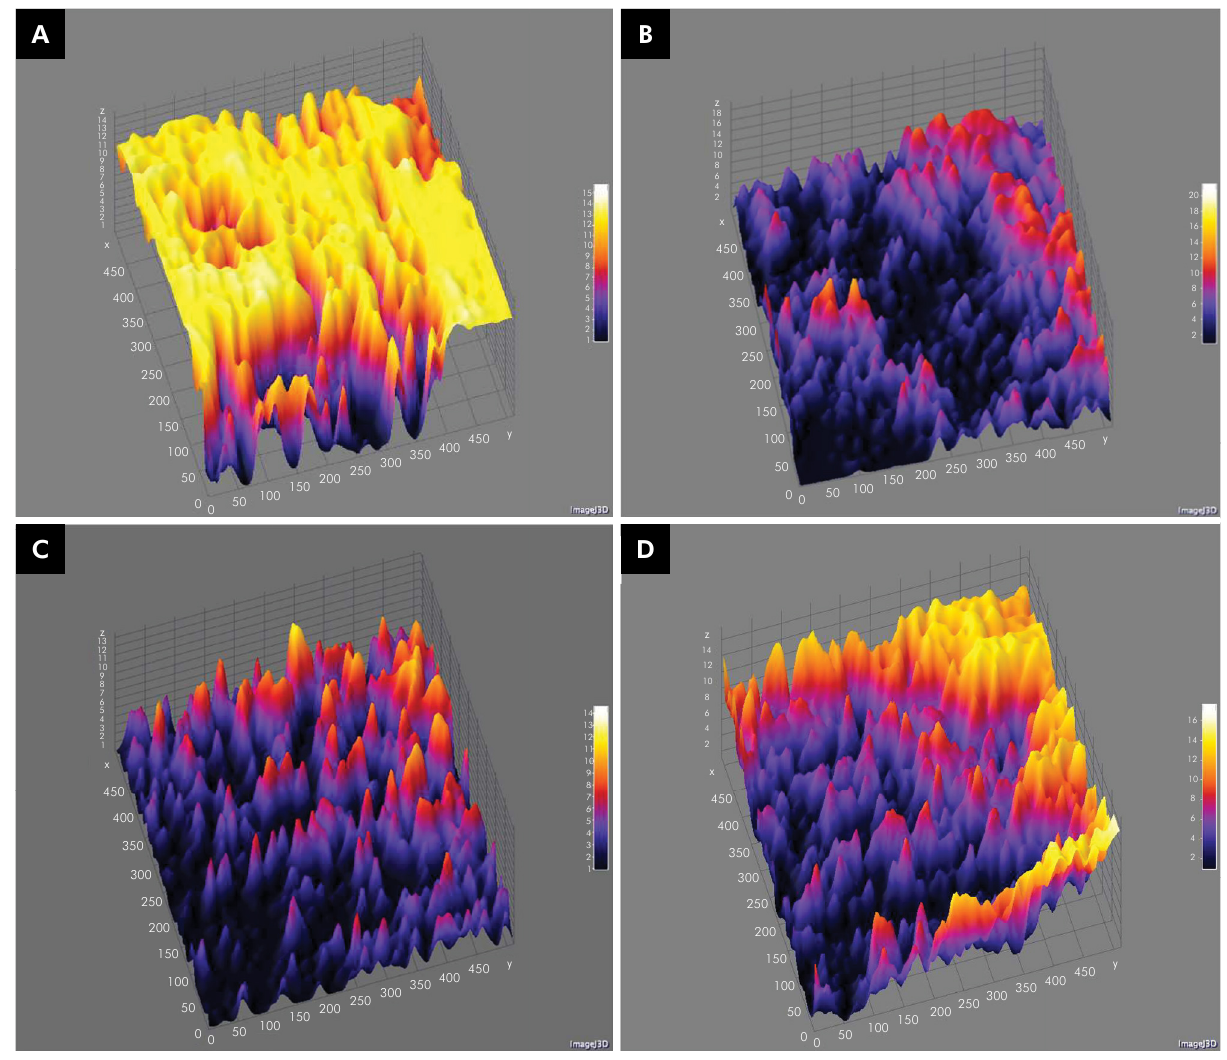
Figure 6. Surface topography of control surfaces and polished surfaces (after step 4). Graphs derived by ImageJ from confocal microscopy data. Peaks (yellow) and troughs (purple) indicative of the uniformity of the surface. a) Machined disk control surface. b) Machined disk polished surface. c) Moderately roughened disk control surface. d) Moderately roughened disk polished surface.